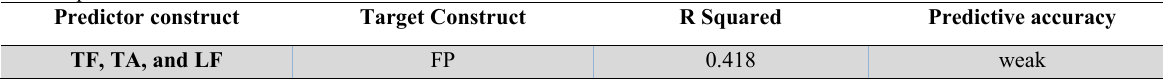
The R square Value Predictor construct Target Construct R Squared Predictive accuracy TF, TA, and LF FP 0.418 weak